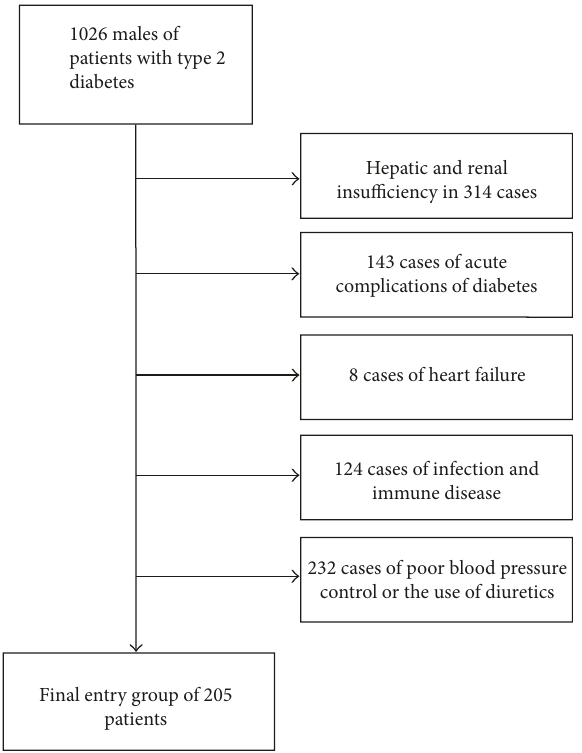
Figure 1: Flowchart showing criteria for patient